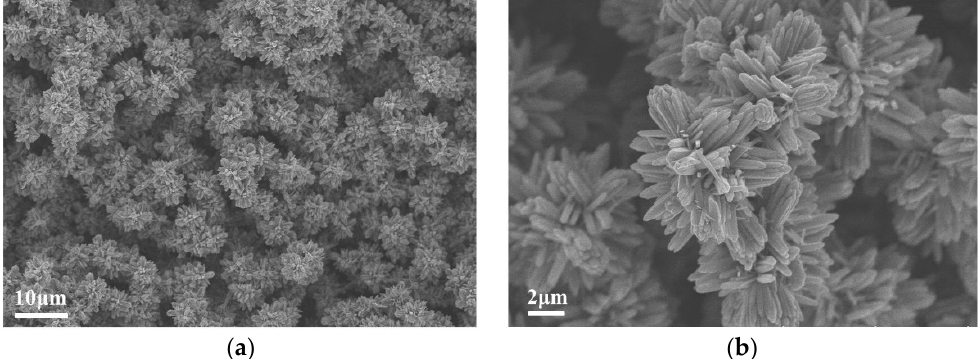
Figure 4. ( a ) Top view of HR-SEM image of synthesized TiO 2 nano-flowers, which show the randomly oriented flower-like nanostructures. ( b ) The high-magnified HR-SEM image of TiO 2 nano-flowers.